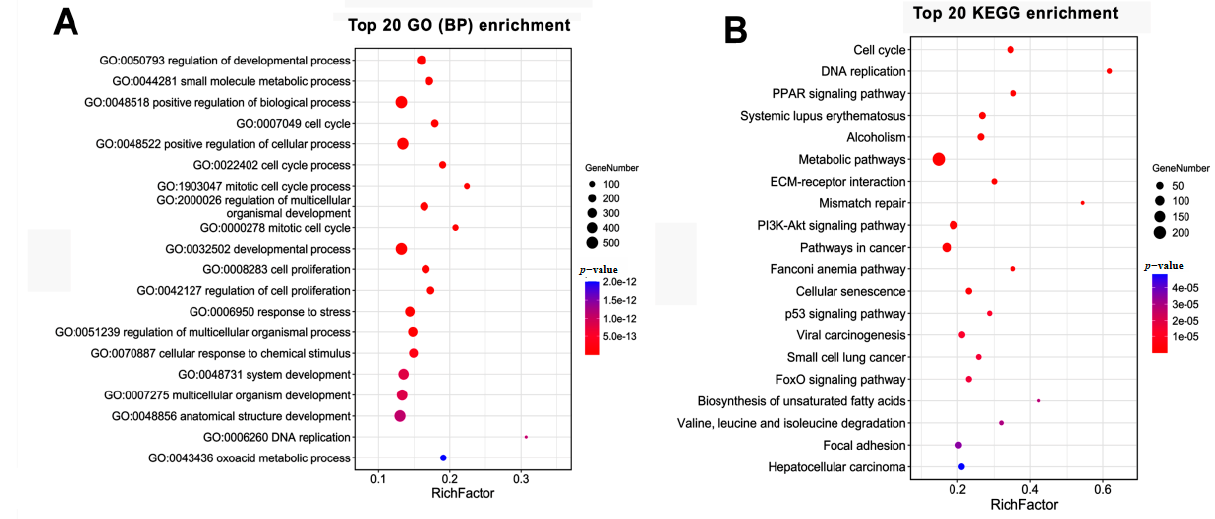
Figure 8. GO and KEGG enrichment analysis of the DE mRNAs targeted by DE LncRNAs. ( A ) Top 20 GO enrichment terms (biological process). ( B ) Top 20 KEGG enrichment pathways.